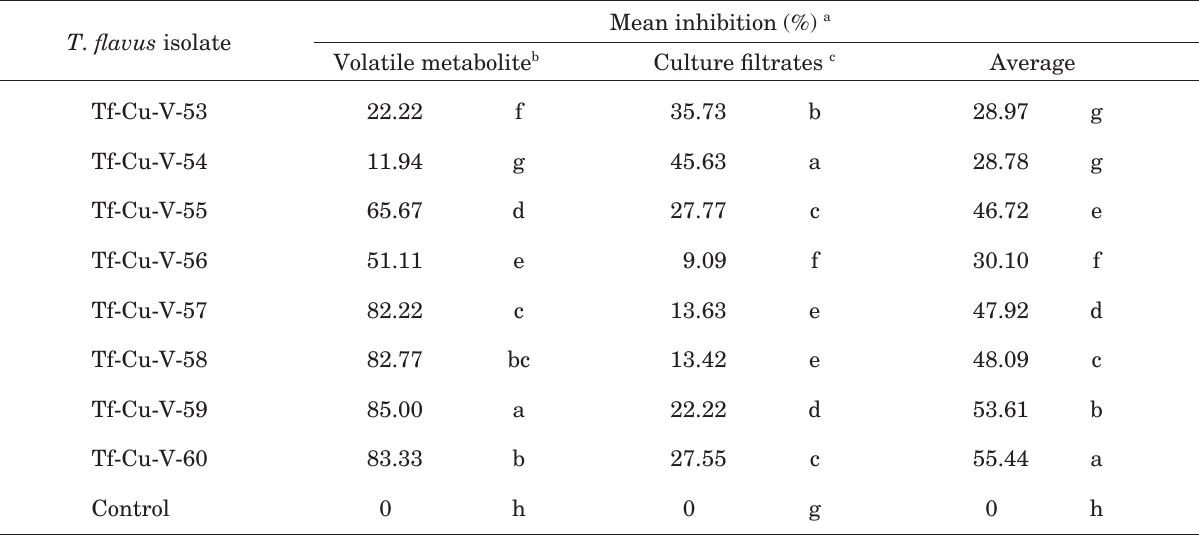
Table 1. Inhibitory effects of volatile metabolites and culture filtrates from various Talaromyces flavus isolates on growth of Verticillium albo-atrum .